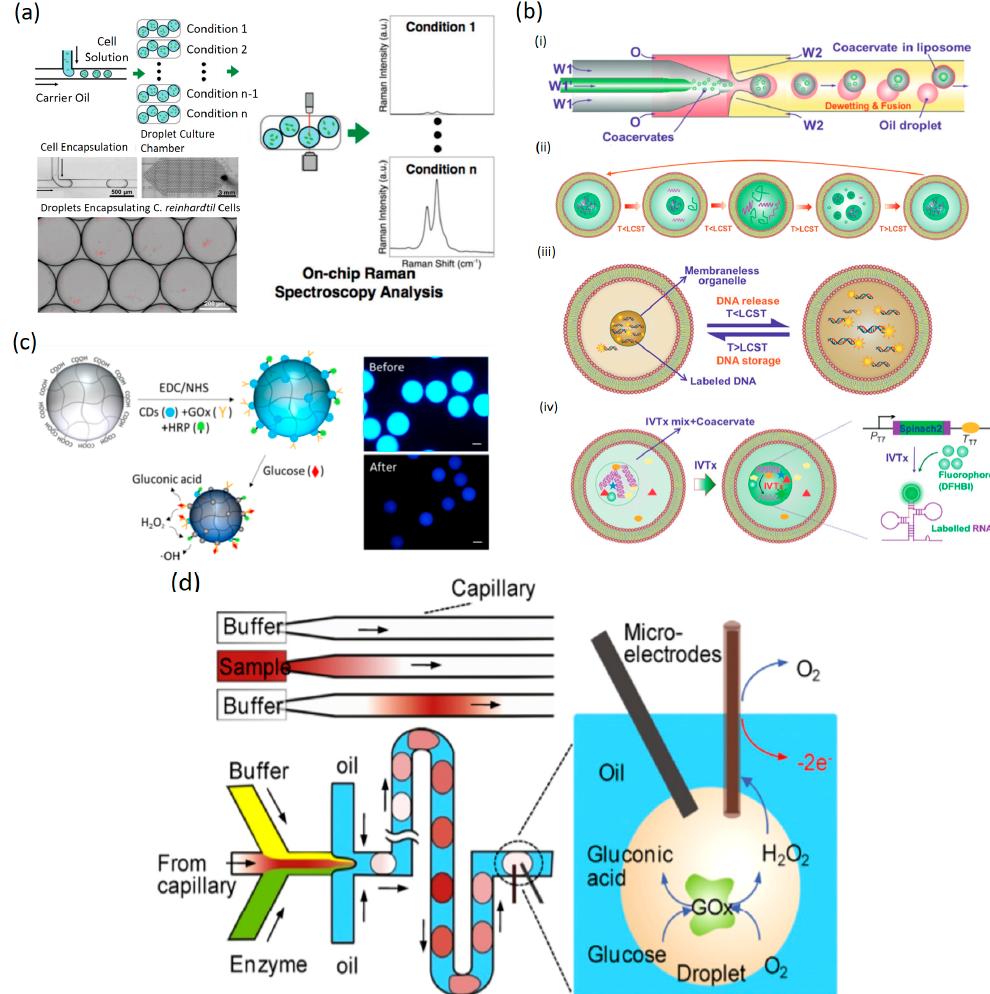
Figure 5. Droplet-based microfluidics for metabolites. ( a ) Overview of Raman spectroscopy integrated with a polydimethylsiloxane (PDMS) droplet microfluidic platform for on-chip